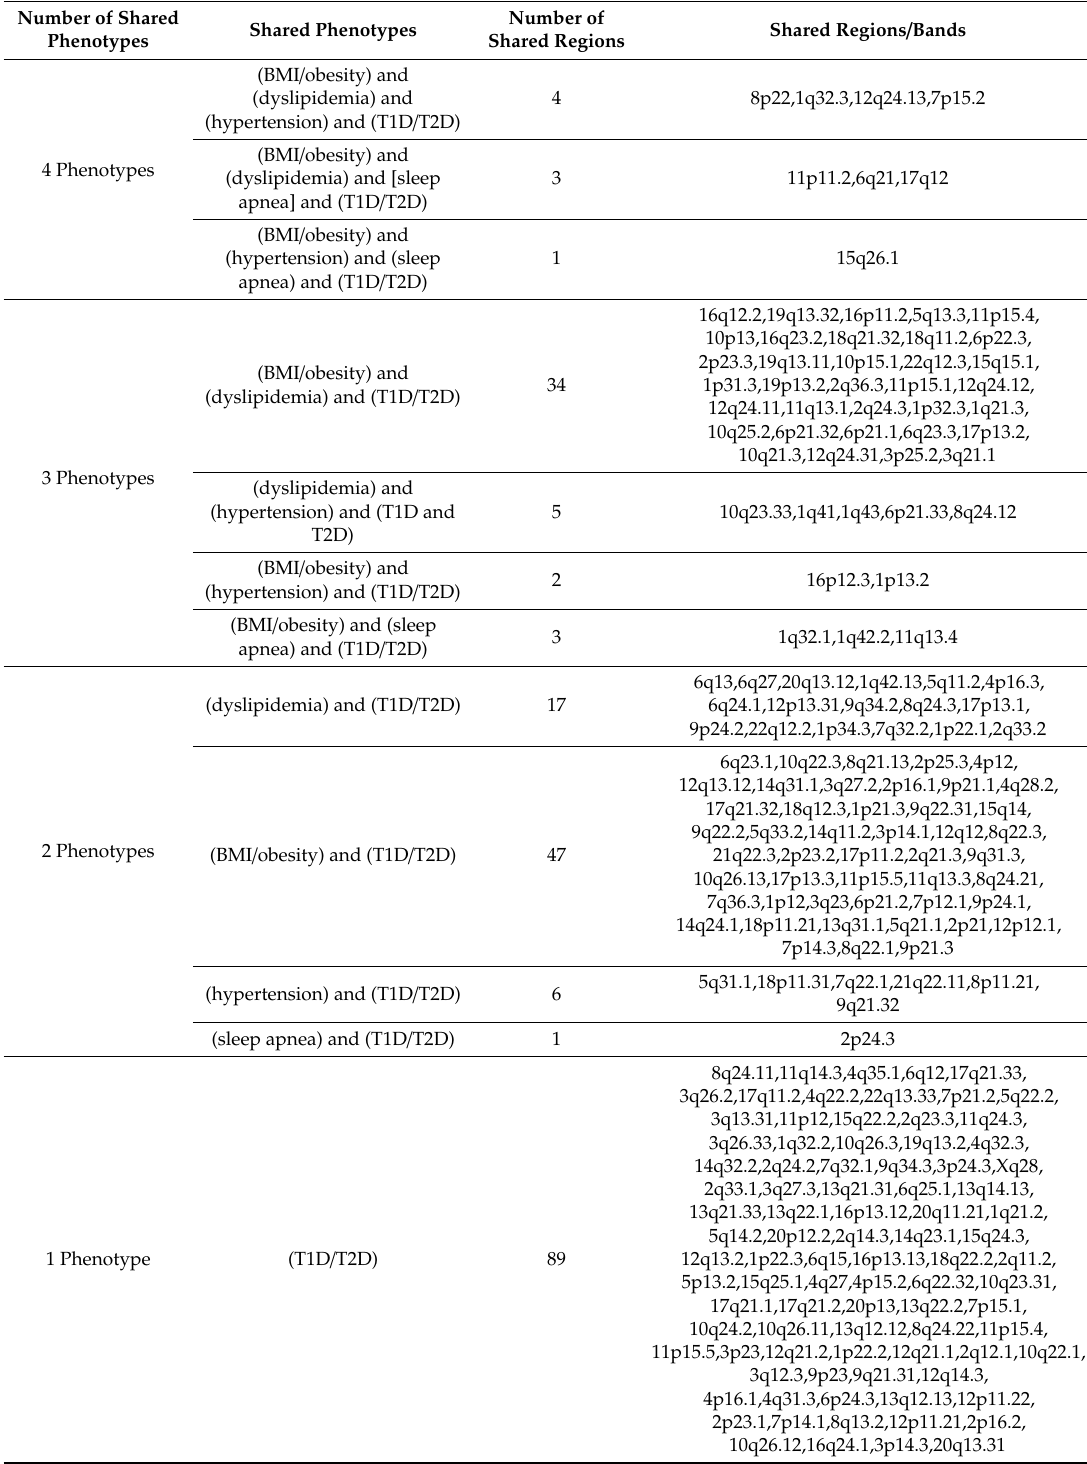
Table 1. List of overlapped chromosomal regions that correlated with UAEDIAB-phenotypes and